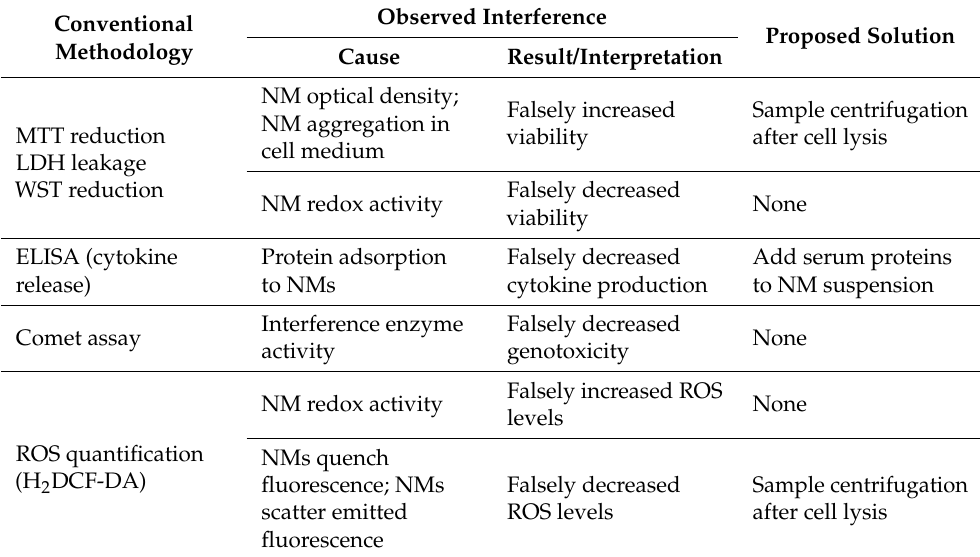
Table 1. Main interferences from nanomaterials in some of the most widely used conventional toxicological assays identified so far. Conventional